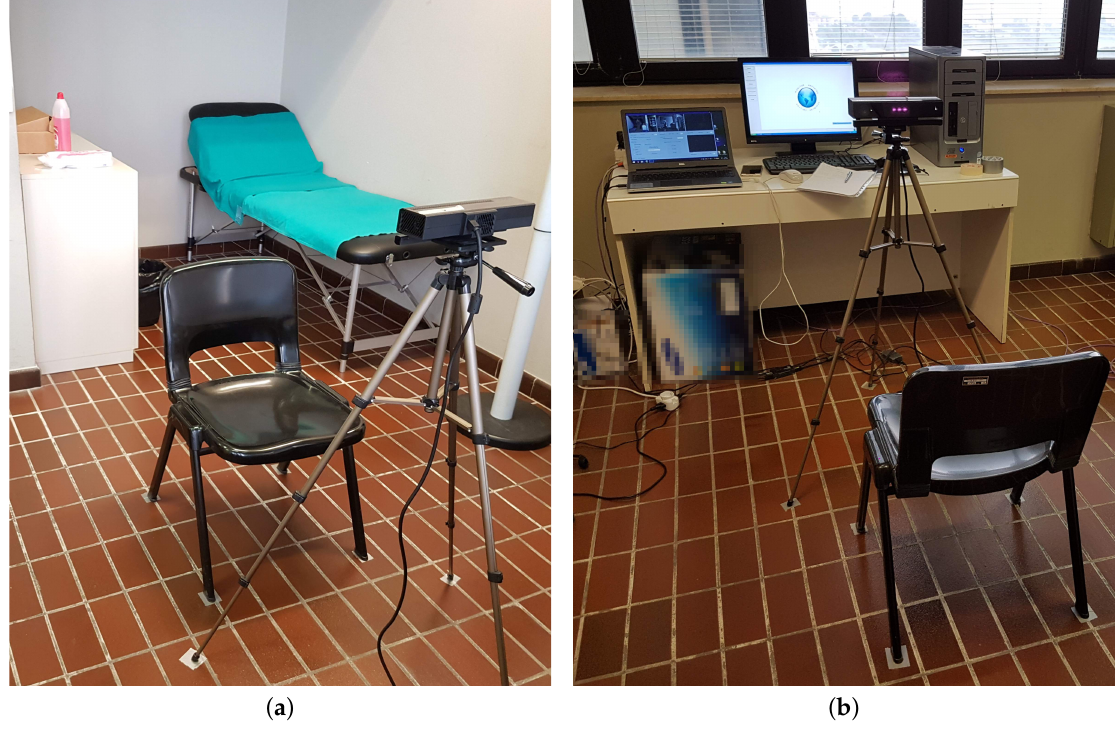
Figure 5. Laboratory setup at Università Politecnica delle Marche, where the tests have been conducted. Two different environmental conditions are shown: high ( a ) and low ( b )